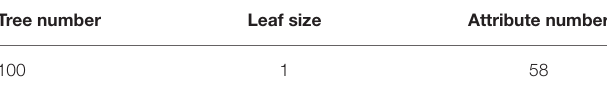
TABLE 2 | Decision tree parameters.